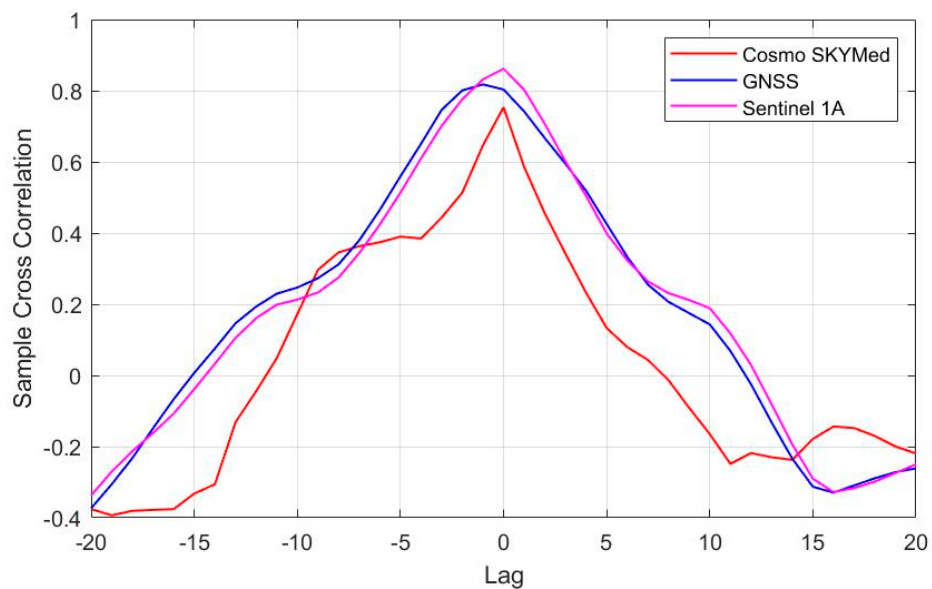
Figure 8. Cross-Correlation histogram between groundwater level and land subsidence derived from GNSS, COSMO-SkyMed, and Sentinel-1.